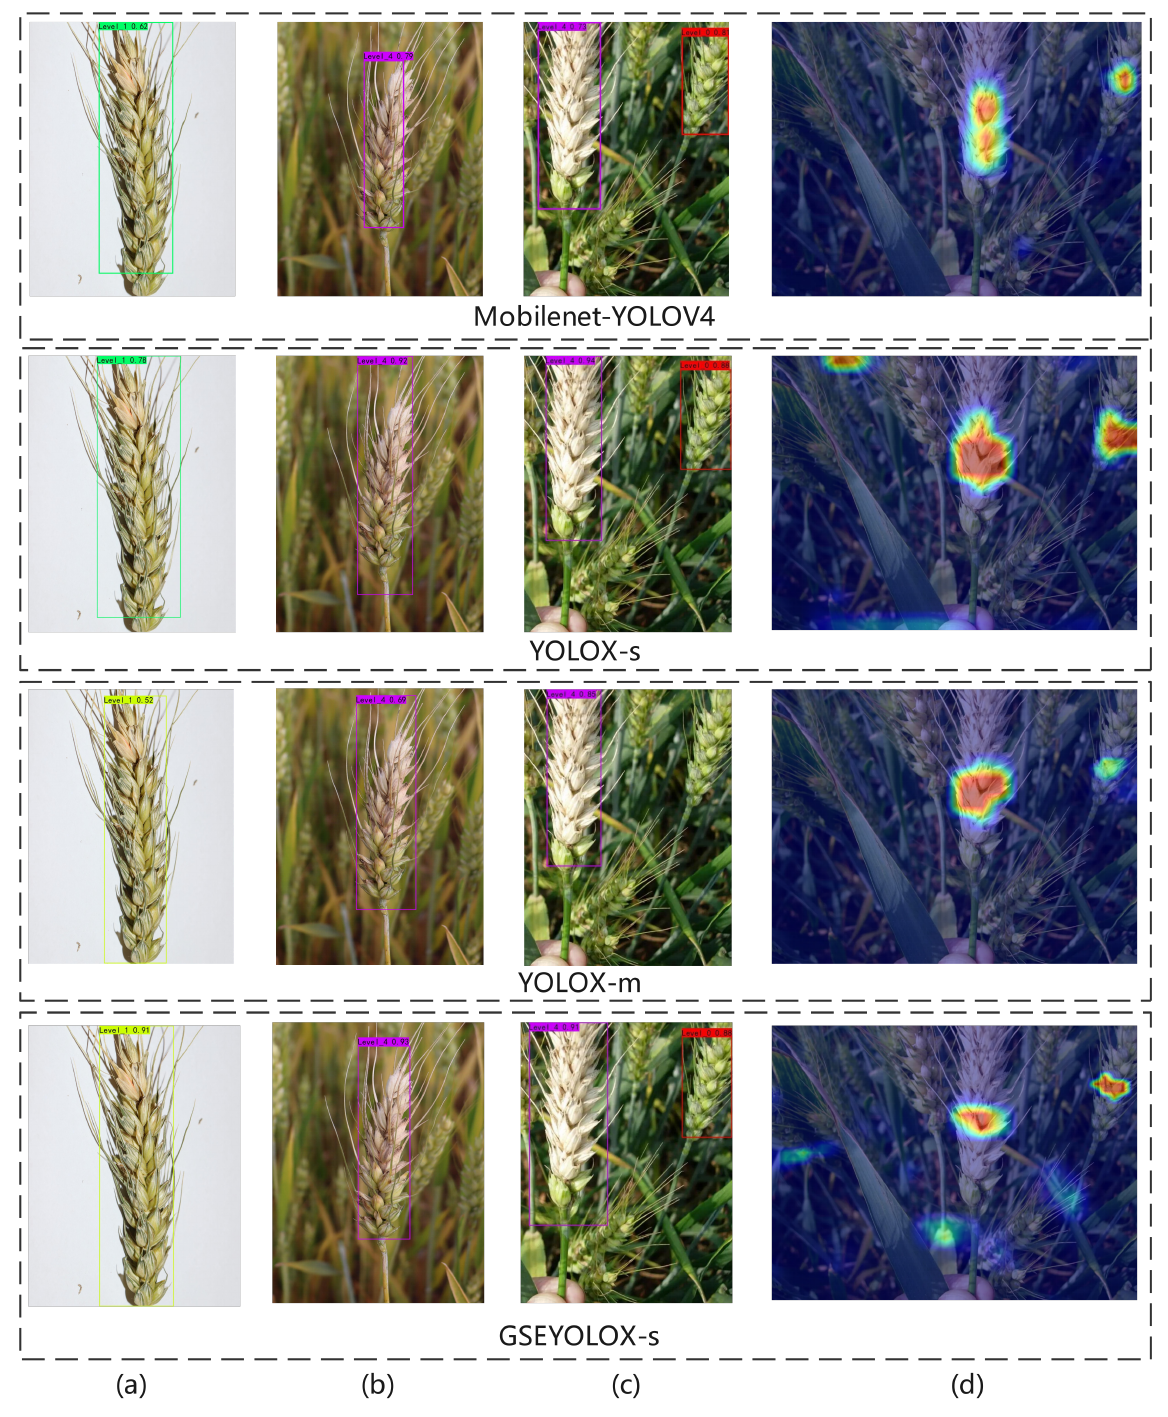
Figure 6. Visualization of detection results on FHBSGD. ( a ) Single wheat ear in laboratory scenes; ( b ) Single wheat ear in field scenes; ( c ) Multiple wheat ears in field scenes; ( d ) Heatmaps of detec- tion